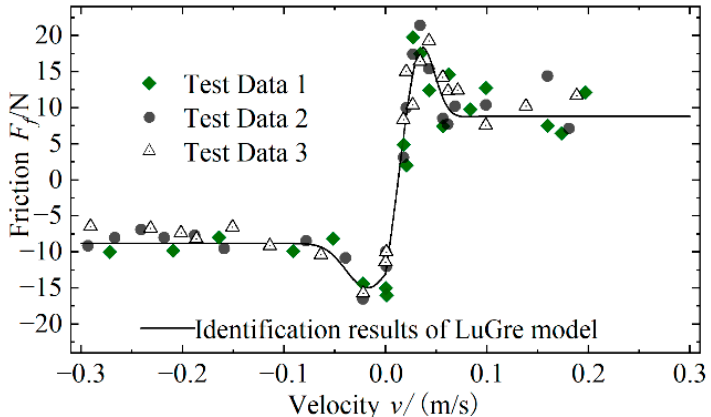
Figure 6. Friction identification results of ELA.